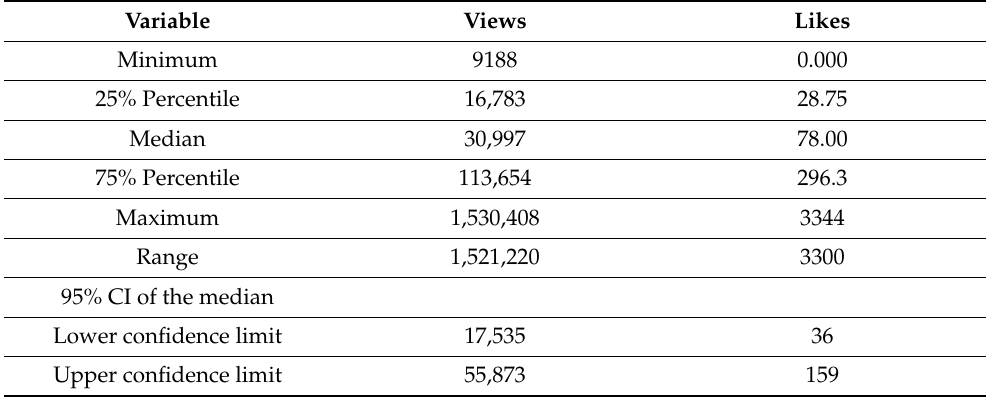
Table 1. Descriptive statistics of views and likes of all 30 rated videos with percentiles and 95% confidence intervals of the